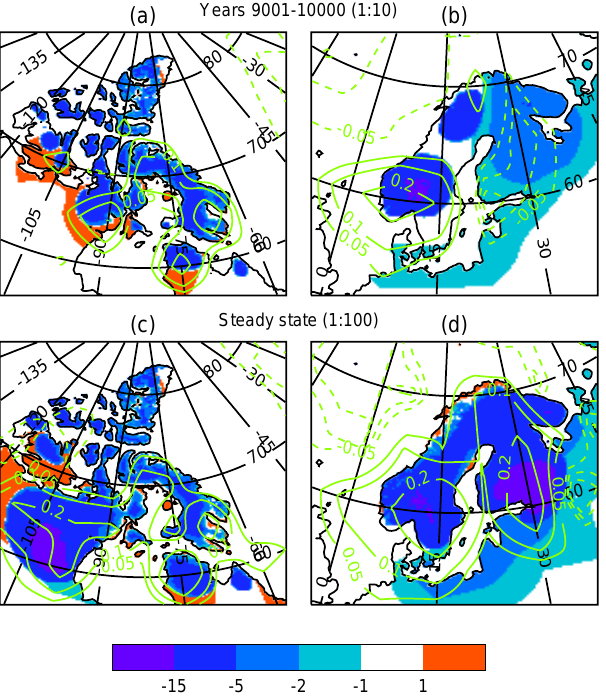
Fig. 12. Difference in the Glimmer surface air temperature (K) be- tween the time-means indicated and the time-mean of years 1–100 of the synchronously coupled experiment for the incipient glacial climate, shown by colours. Contour lines are superimposed show- ing the difference in precipitation (ma − 1 liquid water equivalent).